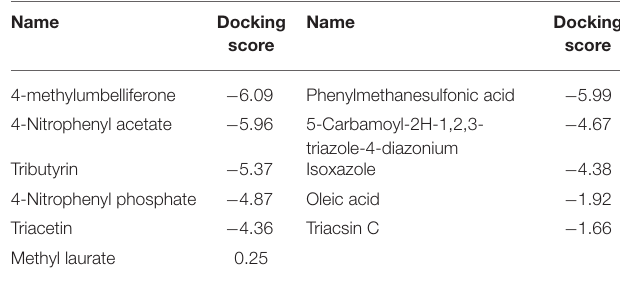
TABLE 1 | Docking scores of different substrates and inhibitors with the esterase model.